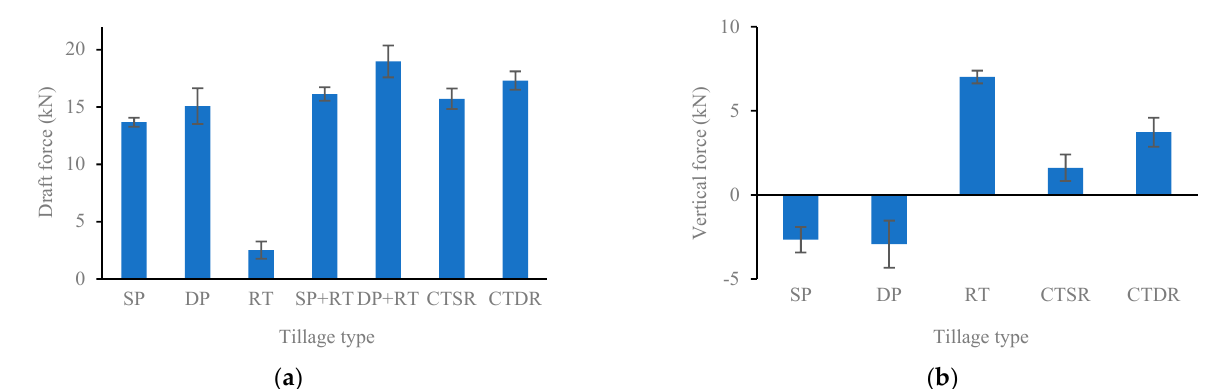
Figure 5. The draft and vertical forces of different tillage types: ( a ) draft force and ( b ) vertical force. (Bar graph represents the mean value, and error bars represent standard deviations).